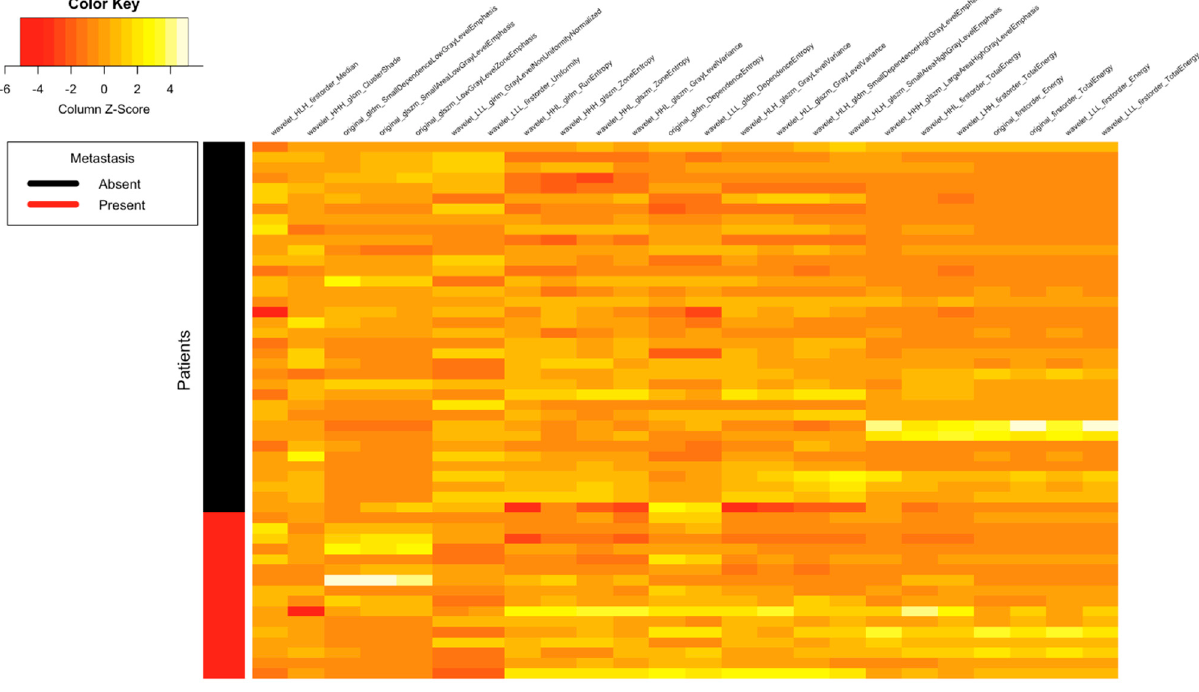
Figure 3. Heat map showing correlation between different radiomics and ADC features with the two classes of recurrence (absent and present).